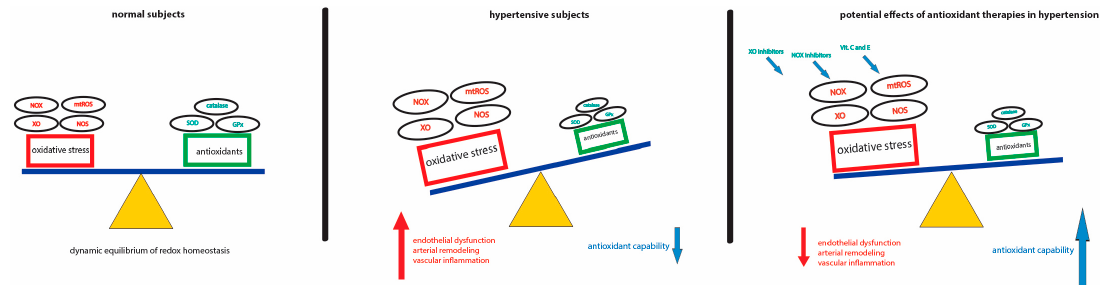
Figure 1. Schematic representation of ROS-mediated damage in hypertension and potential therapeutic approaches. The dynamic equilibrium of ROS production/clearance is balanced in physiological conditions ( left ). In hypertensive setting, the loss of redox homeostasis, characterized by a reduced antioxidant capability and increased ROS production, drives endothelial dysfunction, arterial remodeling and vascular inflammation ( middle ). Selective and specific ROS scavengers may be a novel approach to the treatment of hypertension-associated oxidative damage ( right ).